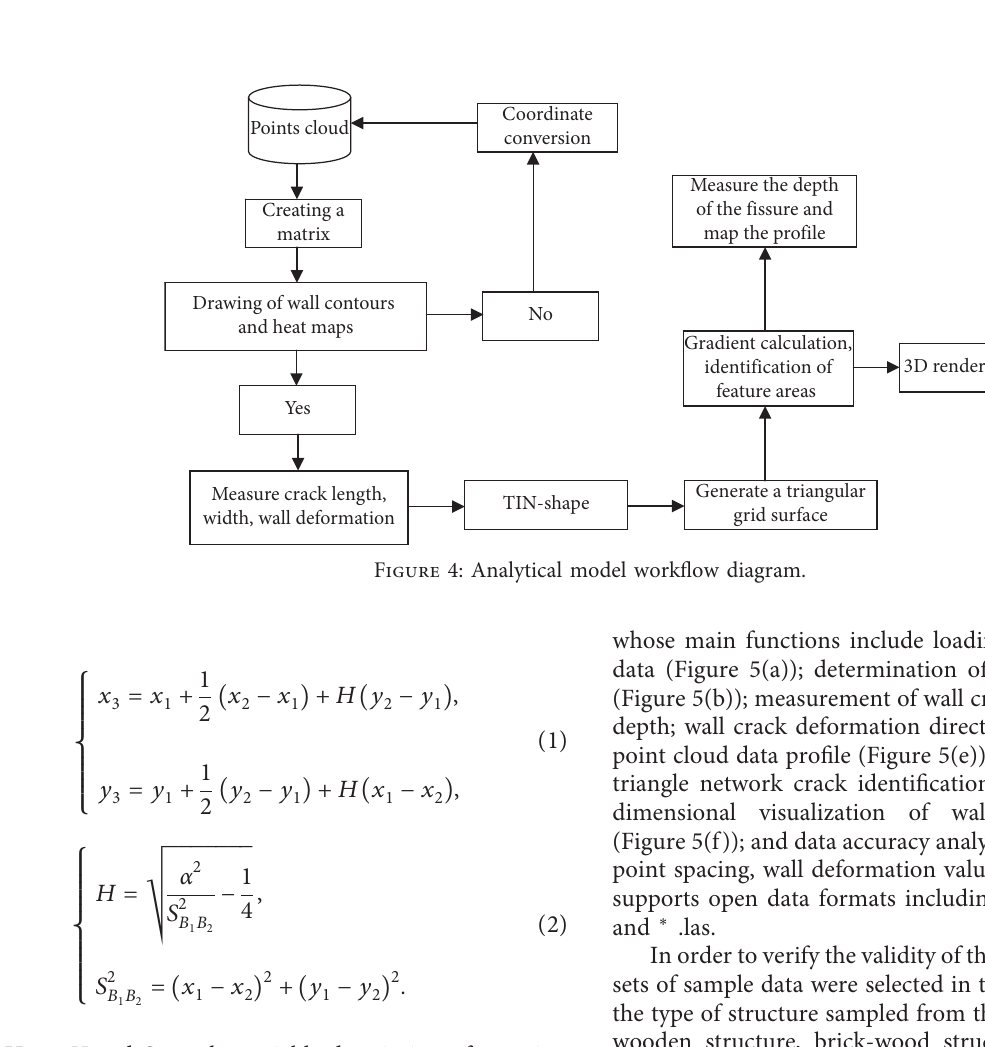
Figure 3: Converted data with coordinates.